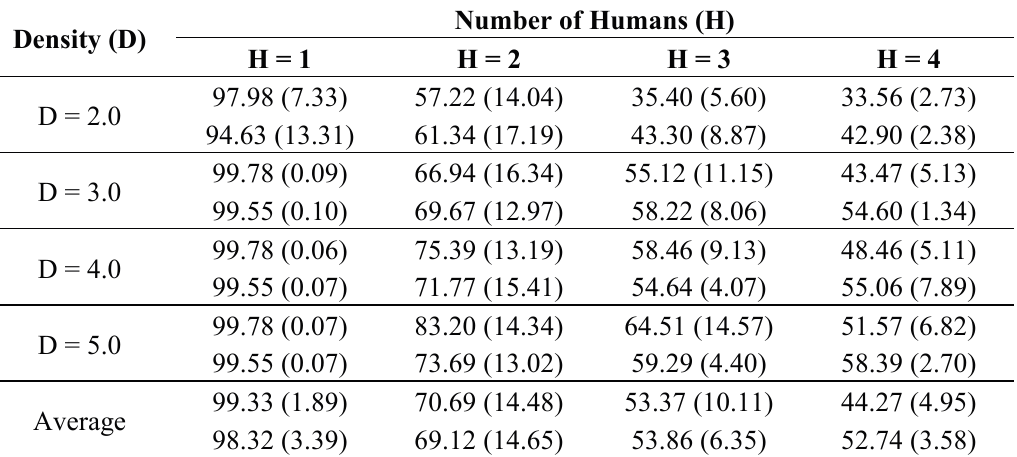
Table 4. Averaged tracking rate (Unit: